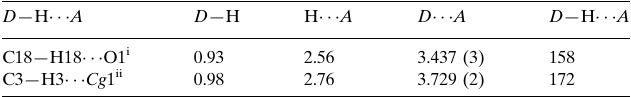
Hydrogen-bond geometry (A˚ , (cid:1) ). Cg 1 is the centroid of the C9–C14